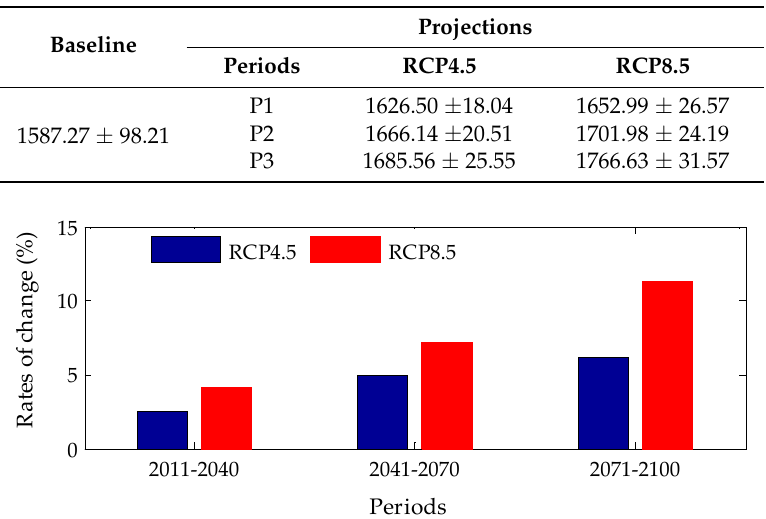
Table 4. Mean of annual PET per period.